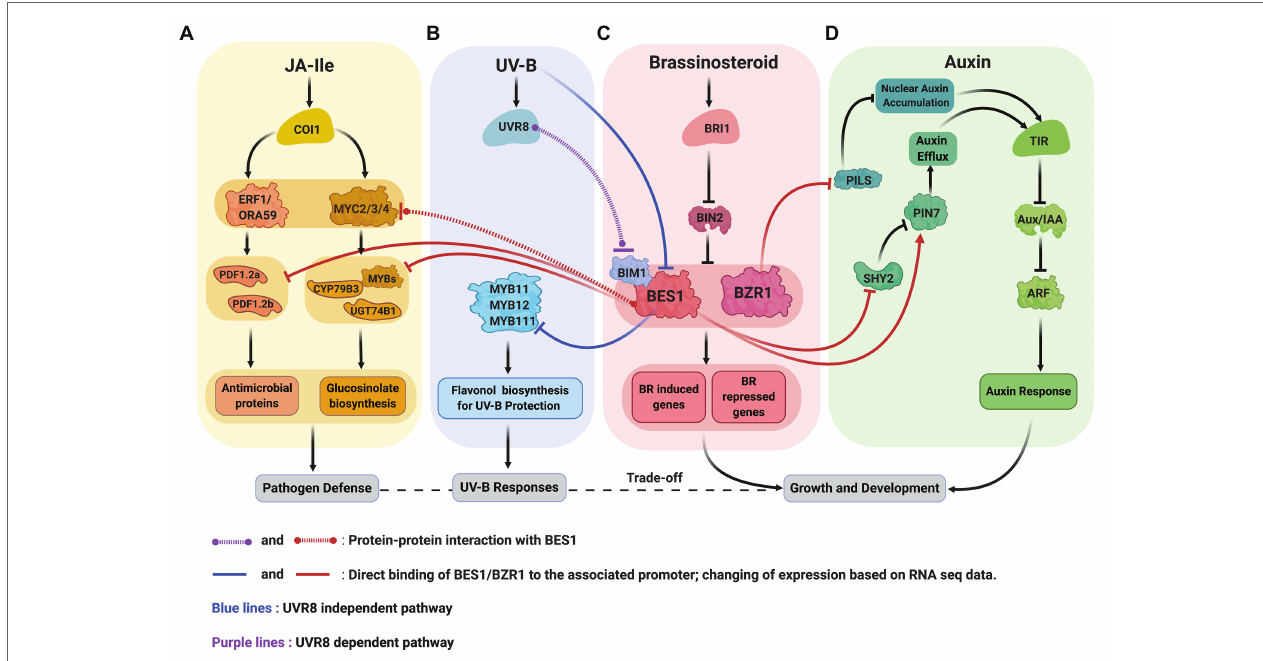
FIGURE 2 | Crosstalk between signaling pathway of BR ( C , red), JA ( A , yellow), UV-B ( B , blue), and auxin ( D , green). (A,C) BR and JA: BES1 restricts the production of defensin (antimicrobial proteins) by repressing the expression defensin genes, PDF1.2a and PDF1.2b. BES1 also negatively regulates the production of glucosinolates (GS) by inhibiting the transcriptional activity of MYC2, repressing GS biosynthesis transcription factors (MYBs) and genes (CYP79B3 and UGT74B1). (B,C) BR and UV-B: UV-B activated UVR8 and represses the function of BES1-BIM1 complexes to reduce the expression of BR induced genes to balance growth and stress (UVR8 dependent pathway). UV-B also reduces BES1 expression allowing the expression of MYB11, MYB12, and MYB111 transcription factors critical for flavonol biosynthesis (UVR8 independent pathway). (C,D) BR and auxin: BZR1 reduces the abundance of PILS protein (ER localized) resulting in auxin’s nuclear accumulation. BES1 increases the abundance of PIN7 that involved in internal auxin flow in the